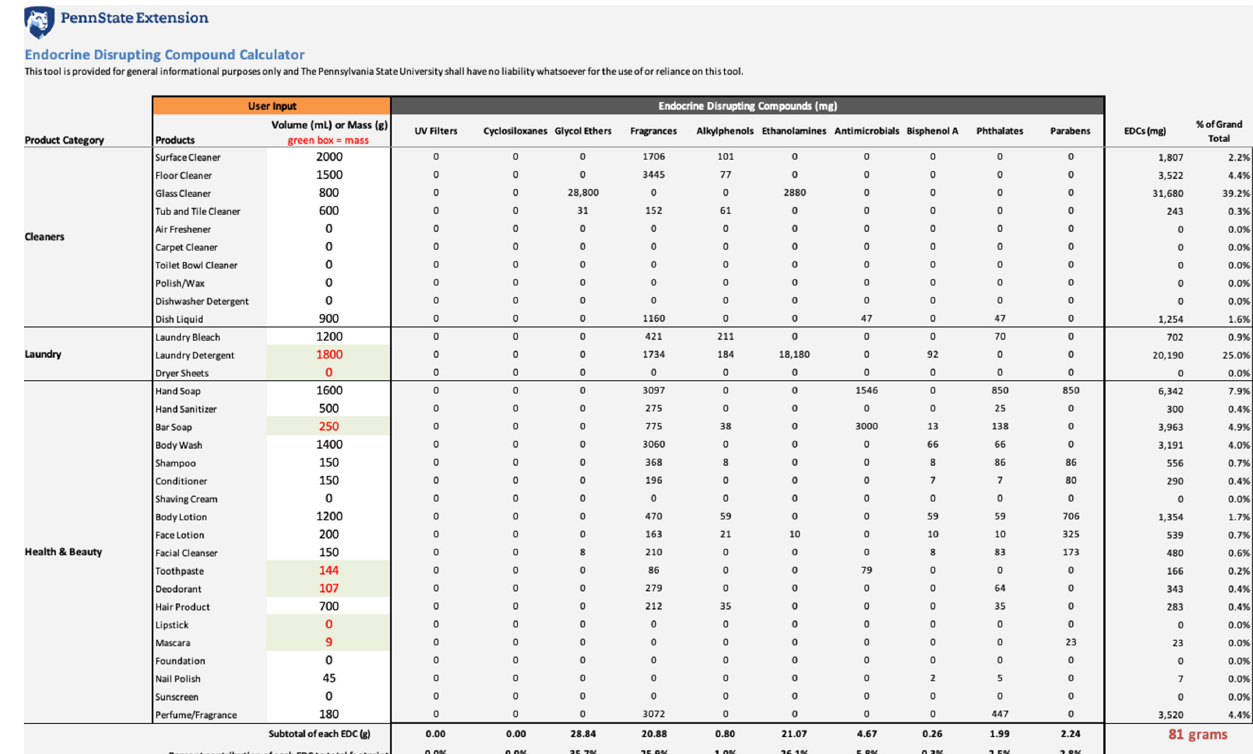
Figure 2. Example of one user’s input to the endocrine-disrupting compound (EDC) footprint calculator and corresponding footprint calculation results, where the amount of each product input in either volume (mL) or mass (g), depending on whether the product is a solid (green box with red text) or a liquid (white box with black text).